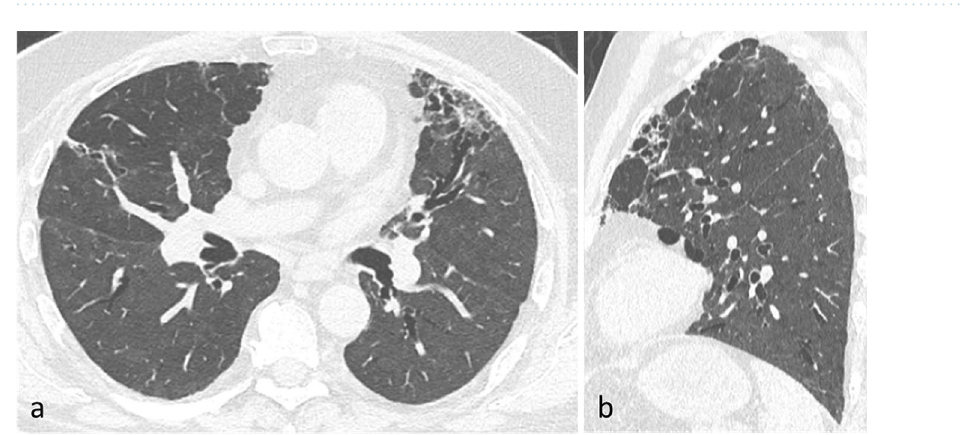
Figure 5. axial ( a ) and sagittal ( b ) CT images representing changes typical of post-ventilatory damage, characterized by cicatricial emphysema, parenchymal bands, and traction bronchiectasis in the anterior portions of upper